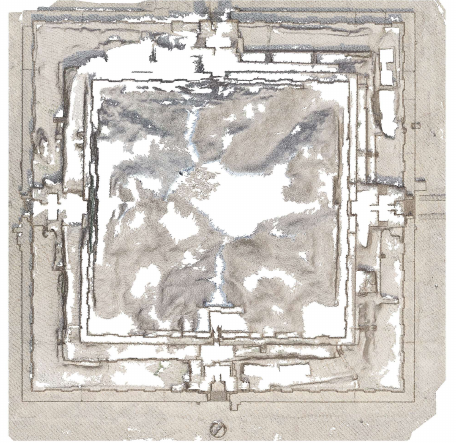
Figure 10. Top view of the LAOUAV dense point cloud.